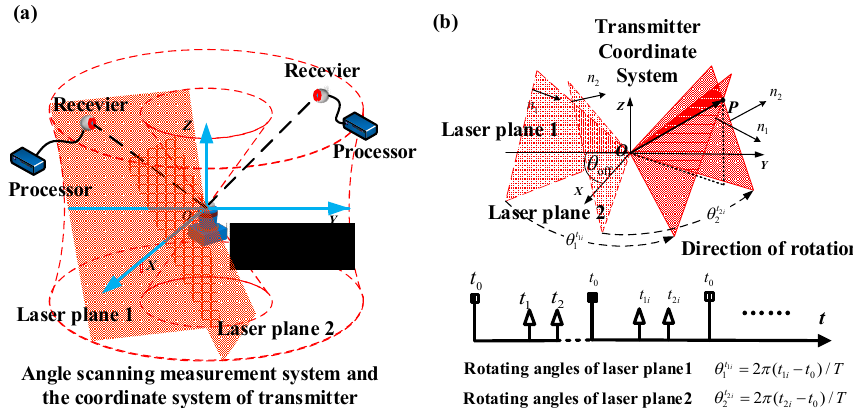
Figure 2. Rotary-laser scanning transmitter system: ( a ) transmitter coordinate system and angle scanning measurement system: transmitter, receiver, two light planes with fixed dip angle emitted by the transmitter; ( b ) schematic diagram of angle measurement.